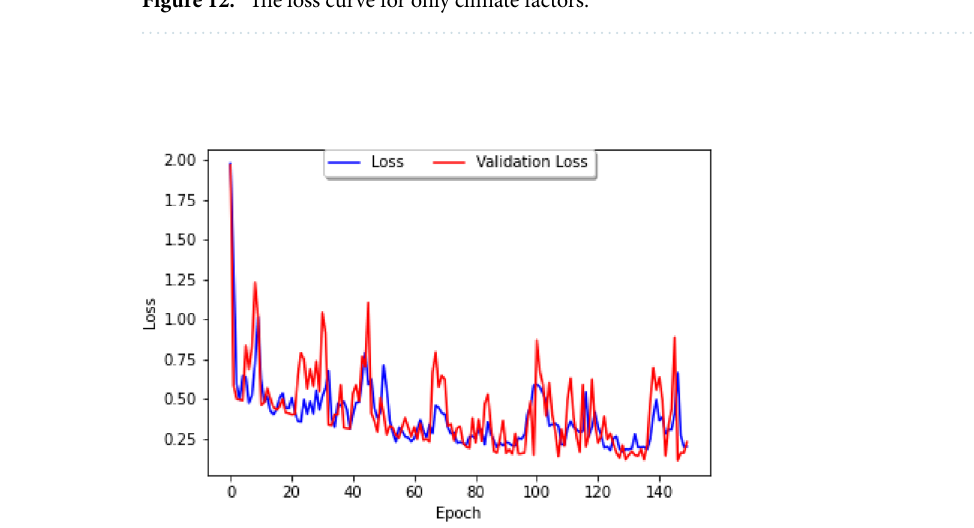
Figure 13. The loss curve for both climate and holidays. Data on the number of reported cases is from Pan- Ameri can Healt h Organ izati on Datas et on Dengue and the WHO dashb oard on COVID- 19. Data on Brazilian climate is from https:// www. visua lcros sing. com/ weath er- histo ry/ brazil.